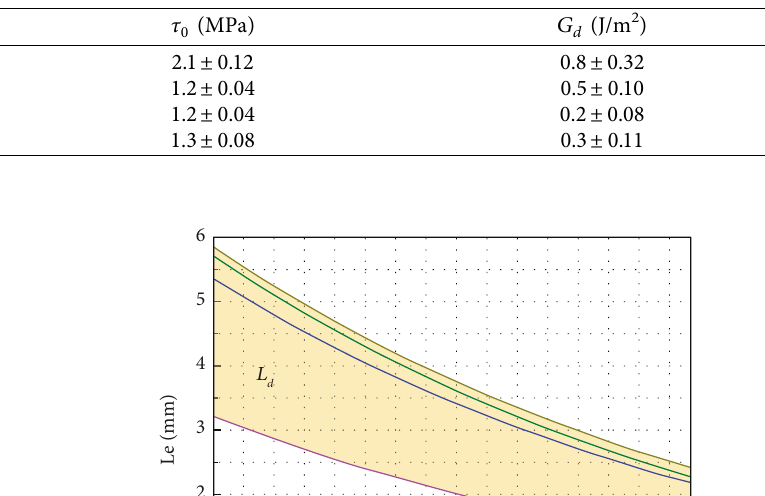
Figure 17: τ and β for different embedment lengths. 0 Table 3: Fiber/matrix interface parameters for PVA fiber.